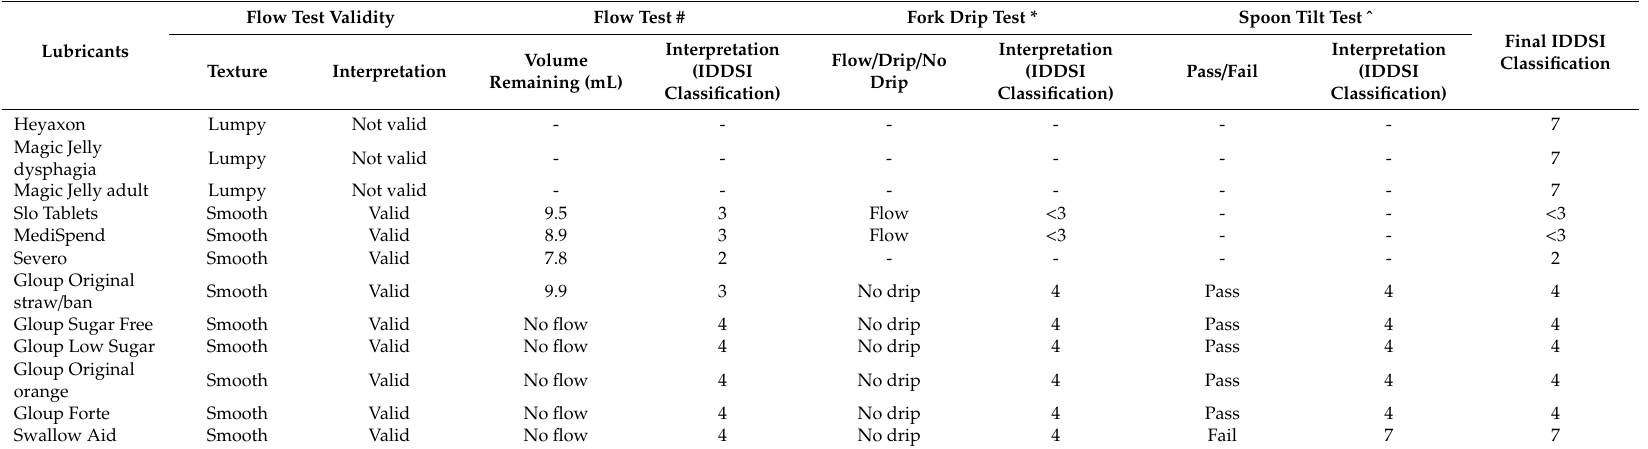
Table 3. Medication lubricant classification according to IDDSI testing methods at fridge temperature (4 ◦ C). Flow test validity (for fluids at all levels): smooth fluids are valid to be tested using the Flow test, while fluids that contain gristle, bone, husks, shell, fibres or lumps are not valid to be tested. Flow test (for fluids at all levels): the volume of fluid remaining in the syringe after 10 s. Fork Drip test (for fluids at level 3 and 4 in the Flow test): fluid drip and flow manner through fork prongs. Spoon Tilt test (for fluids at level 4 in the Fork Drip test): ability of fluid to hold its shape on the spoon and slide o ff easily when spoon is